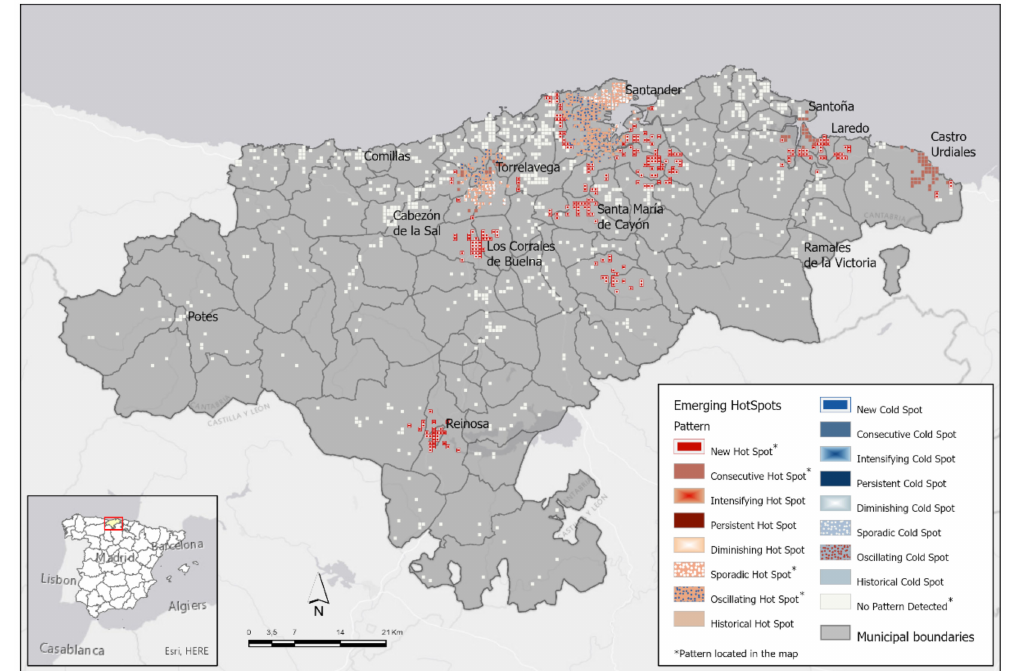
Figure 5. Emerging hotspots for COVID-19 in the Autonomous Community of Cantabria (March–November 2020). Scheme 22 [29]. Source: Own work based on COVID-19 microdata daily records from the health authorities (Government of Cantabria,